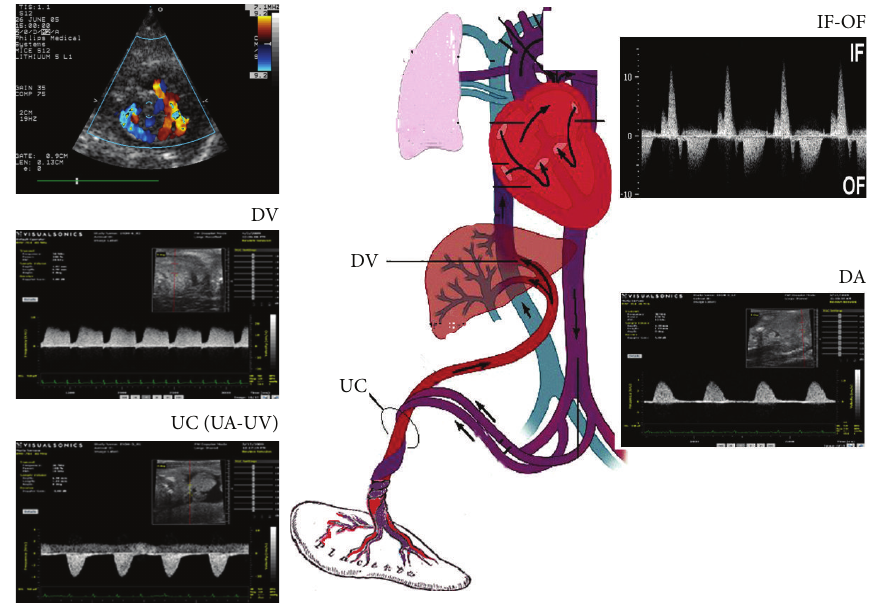
Figure 1: Color Doppler (top left) and pulsed directed Doppler were used to obtain blood waveform patterns. Normal ventricular inflow and outflow (IF-OF) pattern is shown in top right. Locations of waveforms obtained for ductus venosus (DV), descending aorta (DA), and umbilical cord (UC) for umbilical artery (UA) and umbilical vein (UV) are indicated. Permission is granted for the modification of a figure from Merck Source Resource Library, an online Elsevier publication